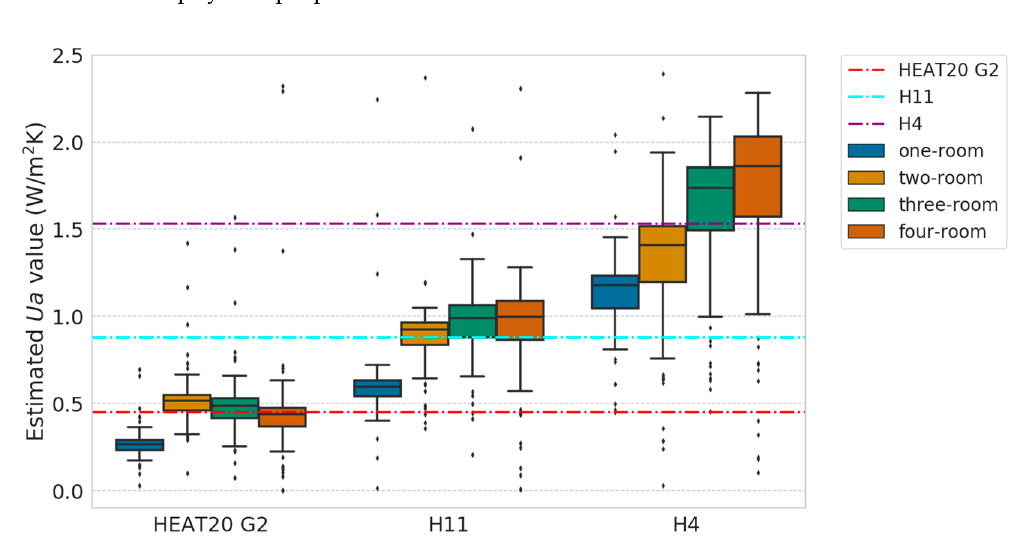
Figure 7. Estimated Ua values for di ff erent simulation data (HEAT20 G2, H11, and H4) and models (one-, two-, three-, and four-room model). The dotted line represents literature Ua values for each standard. Boxplots represent the distribution of estimated results for the di ff erent